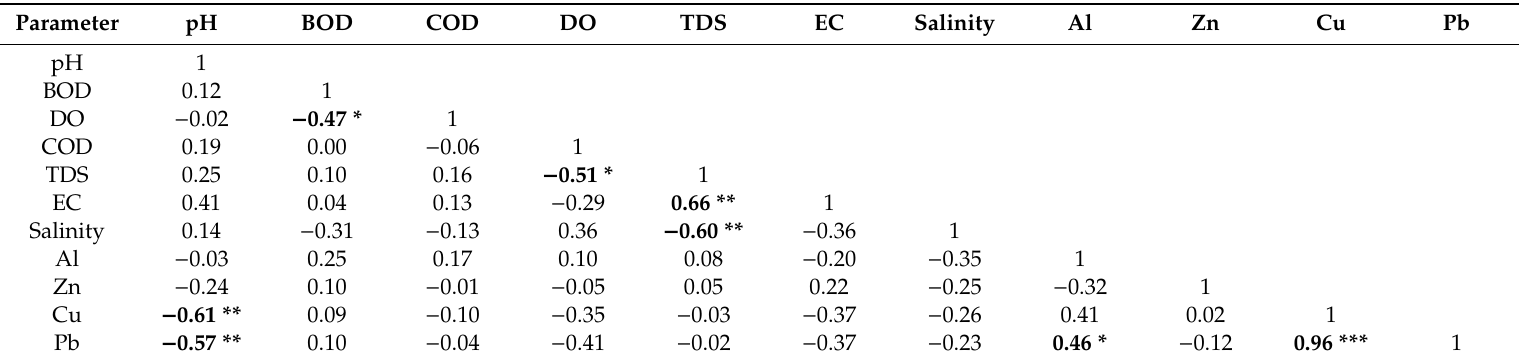
Table 3. Two-tailed Pearson’s correlation coe ffi cients for the physicochemical parameters and toxic heavy contents in the industrial and Leeuwkuil WWTP e ffl uents § .